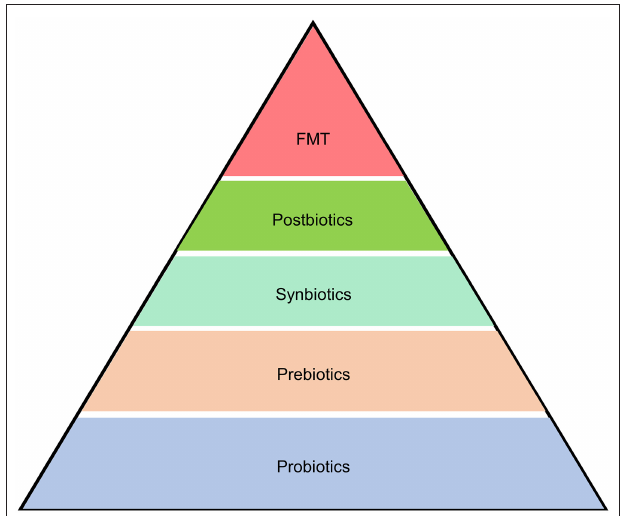
FIGURE 4 | Microbiome-based therapeutics and therapies for pancreatic diseases. Strategies to alleviate pancreatic diseases by modulating the gut microbiome include application of products and treatments like probiotics, prebiotics, synbiotics, postbiotics, and fecal microbiota transplantation